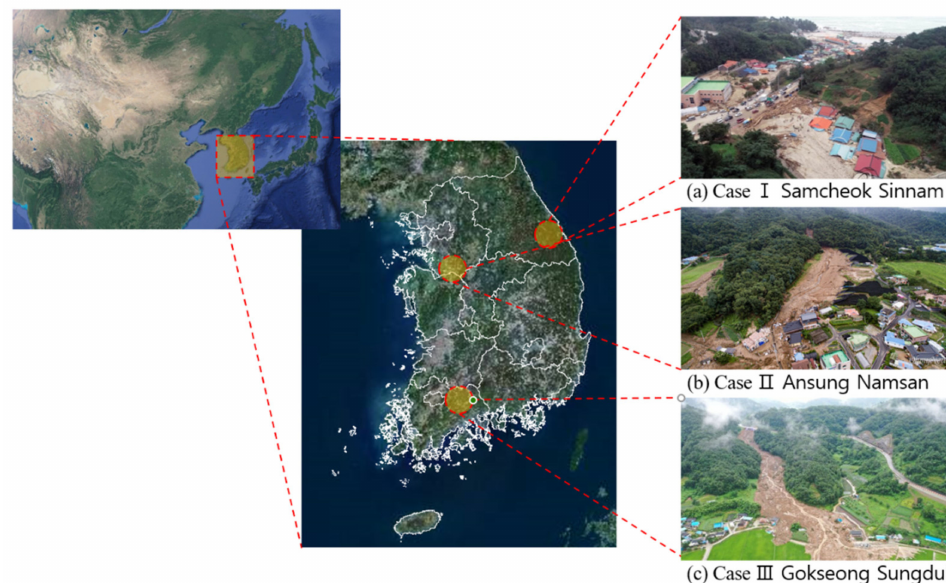
Figure 5. Analyzed areas. ( a ) Samcheok, Gangwon-do, ( b ) Anseong, Gyeonggi-do, ( c ) Gokseong, Jeollanam-do.